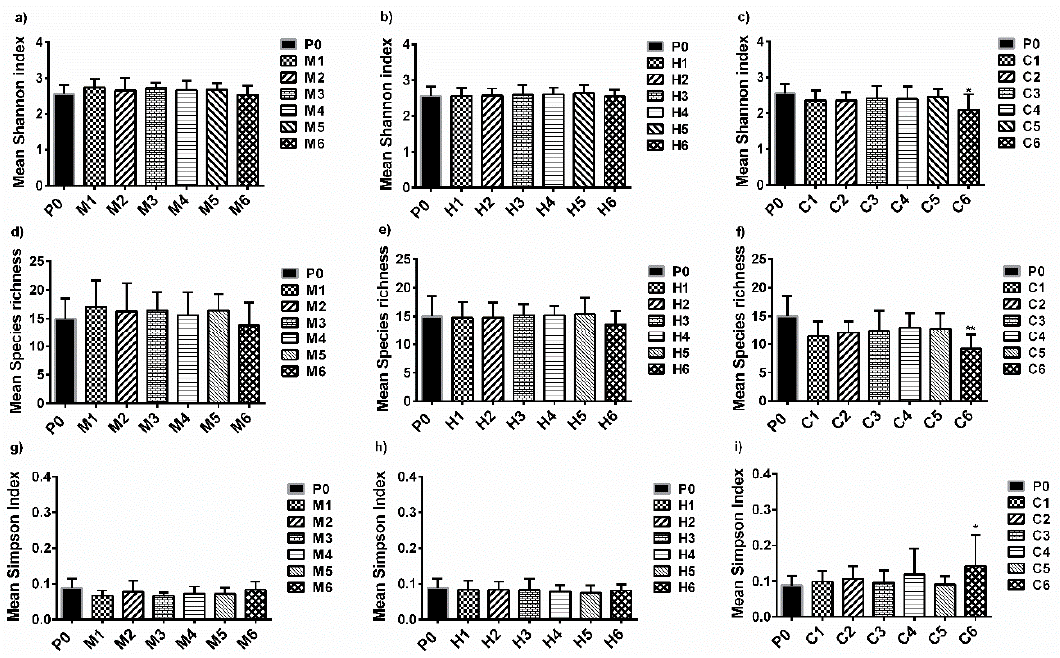
Figure 6. The comparison of the diversity indices, ( a – c ) Shannon diversity index, ( d – f ) species richness, ( g – i ) Simpson index of pioneer bacterial communities on different PDMS-based material surfaces.